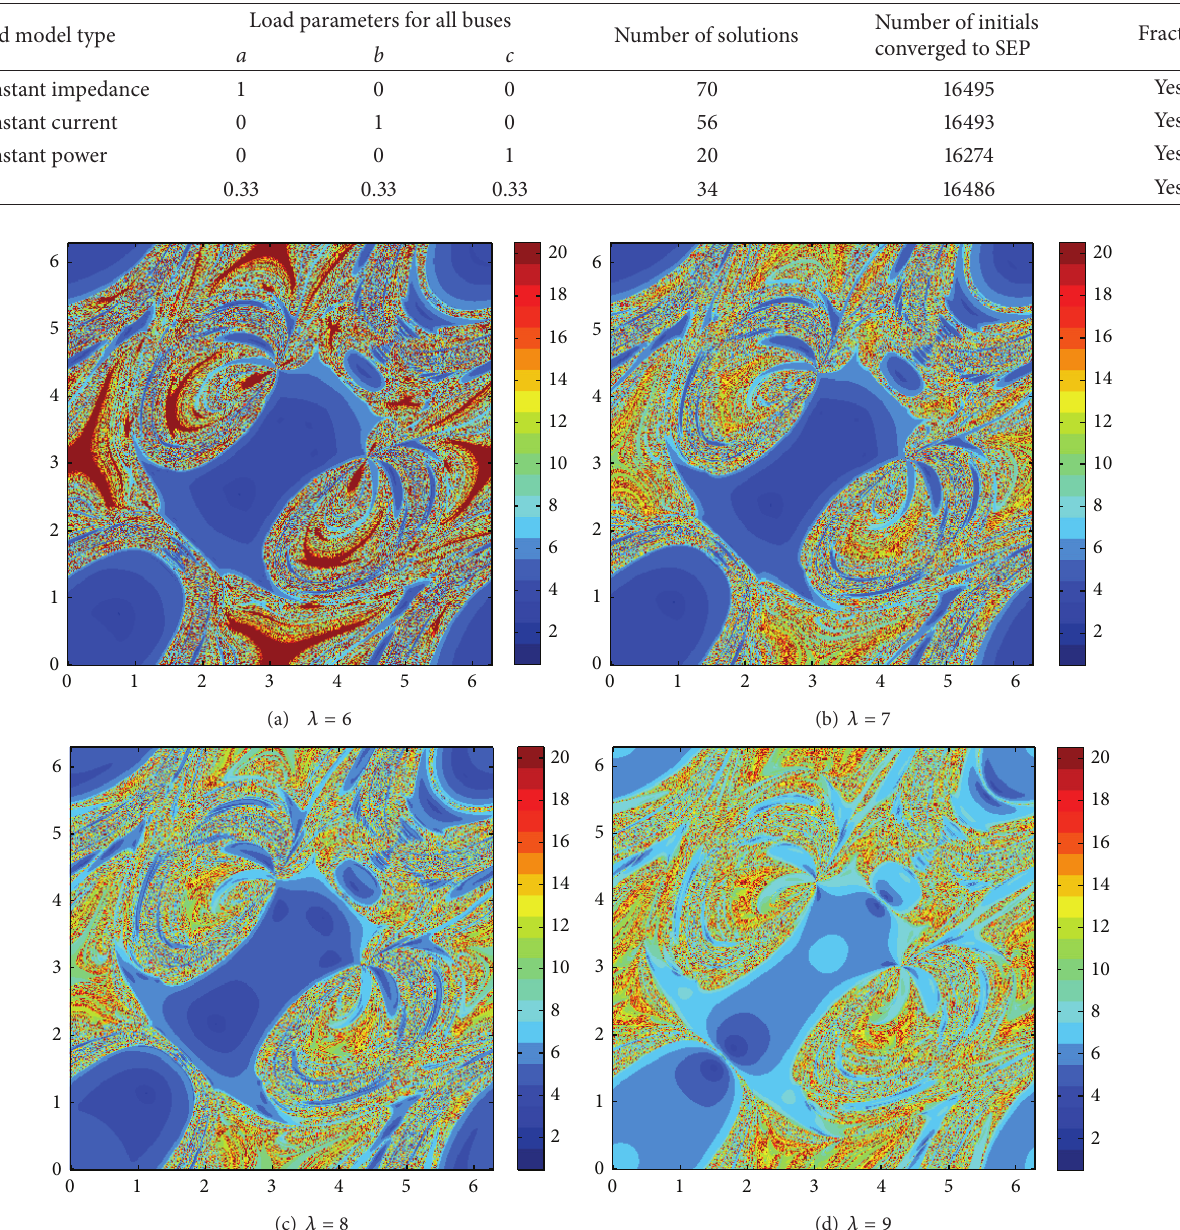
Figure 6: Iteration numbers of Newton method for the modified 3-bus system with different load conditions on ( 𝜃 2 ,𝜃 3 ) plane: (a) 𝜆 = 6 ; (b) 𝜆 = 7 ; (c) 𝜆 = 8 ; (d) 𝜆 = 9